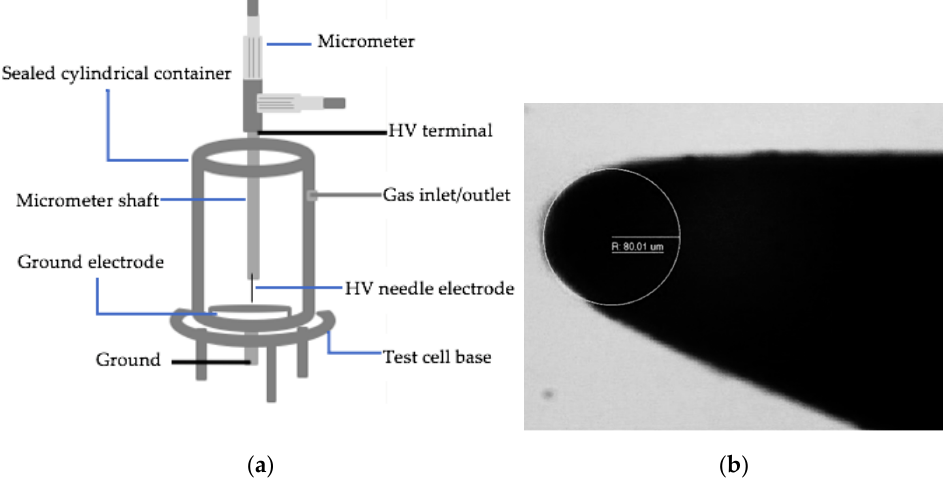
Figure 1. ( a ) Schematic diagram of the test cell (not in scale) with the needle-plane electrode configuration; ( b ) photograph of the gramophone needle tip with ~80µm radius under the microscope.